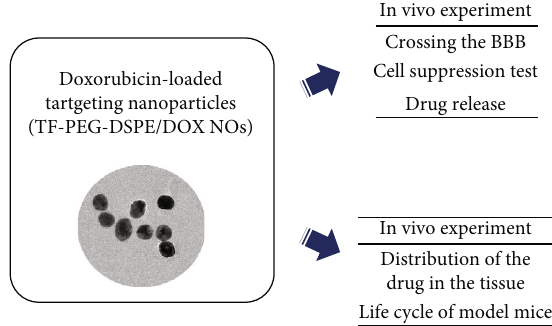
Figure 1: The chemical structural picture of doxorubicin.